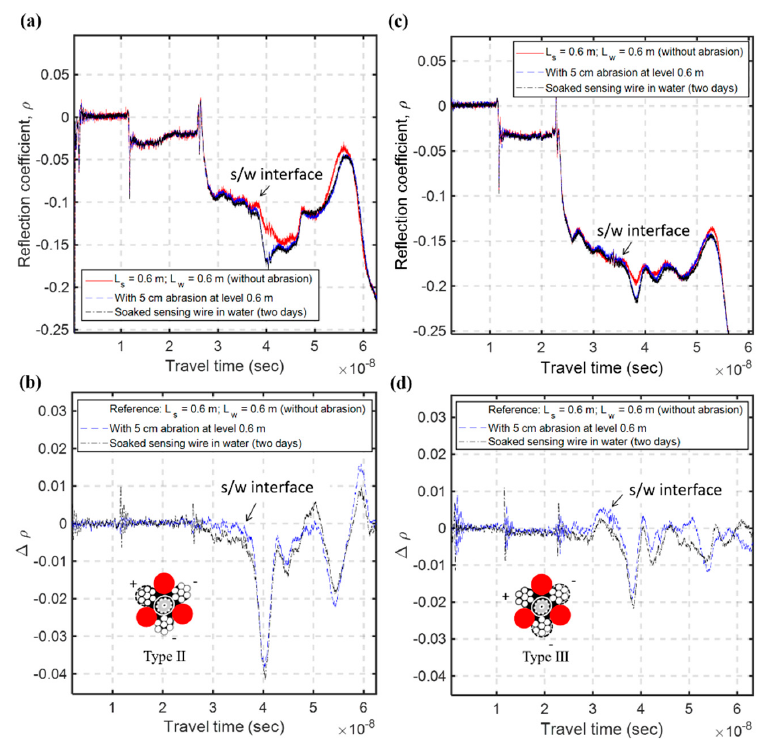
Figure 6. The measured waveforms before abrasion, right after abrasion, and two days after abrasions for Type II ( a ) and Type III ( b ) waveguides; and the corresponding differential waveforms taking the waveform before abrasion as the reference for Type II ( c ) and Type III ( d ) waveguides.